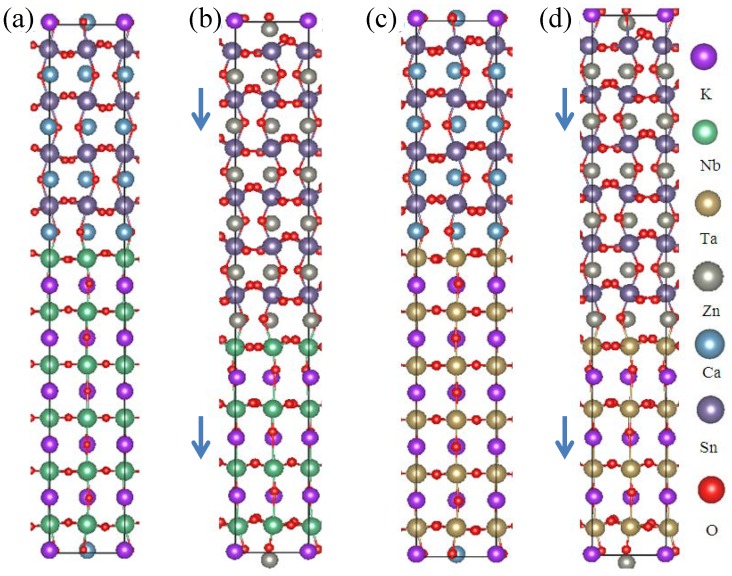
Structures of supercells, left to right (a) KNbO3//CaSnO3, (b) KNbO3//ZnSnO3, (c) KTaO3//CaSnO3, and (d) KTaO3//ZnSnO3.As seen, the structures containing ZnSnO3 have noticeable cation offcentering in the coordinating O cages in both the ZnSnO3 and K(Nb,Ta)O3 parts of the supercells. This corresponds to a ferroelectric polarization. The direction of this is indicated by the arrows on the left of the corresponding structure figures.